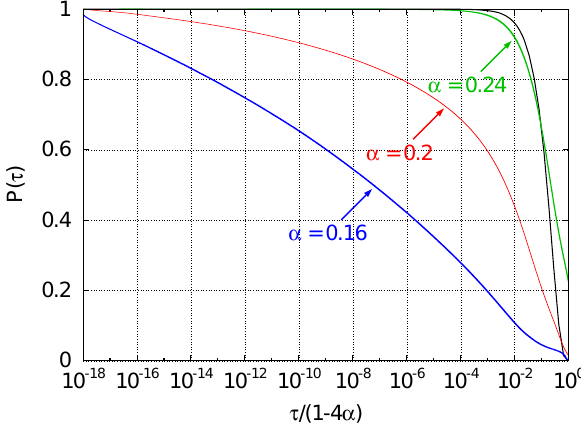
Fig. 4. Cumulative distribution P(τ) of the time spans τ between receiving the last portion of force from a neighbor before becoming unstable and time of instability. The black line shows the distribu- tion that would arise from completely uncorrelated events.